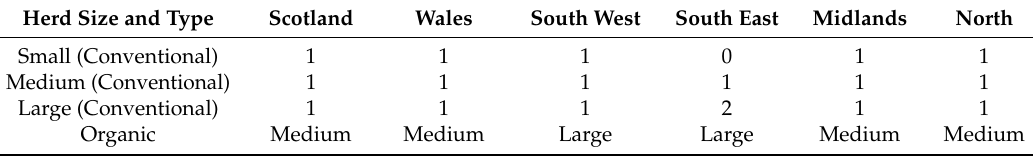
Table 2. Dairy farmers interviewed to investigate attitudes towards disease prevention and control measures according to their location, herd size, and type of enterprise (organic versus conventional). Herd Size and Type Scotland Wales South West South East Midlands North Small (Conventional) 1 1 1 0 1 1 Medium (Conventional) 1 1 1 1 1 1 Large (Conventional) 1 1 1 2 1 1 Organic Medium Medium Large Large Medium